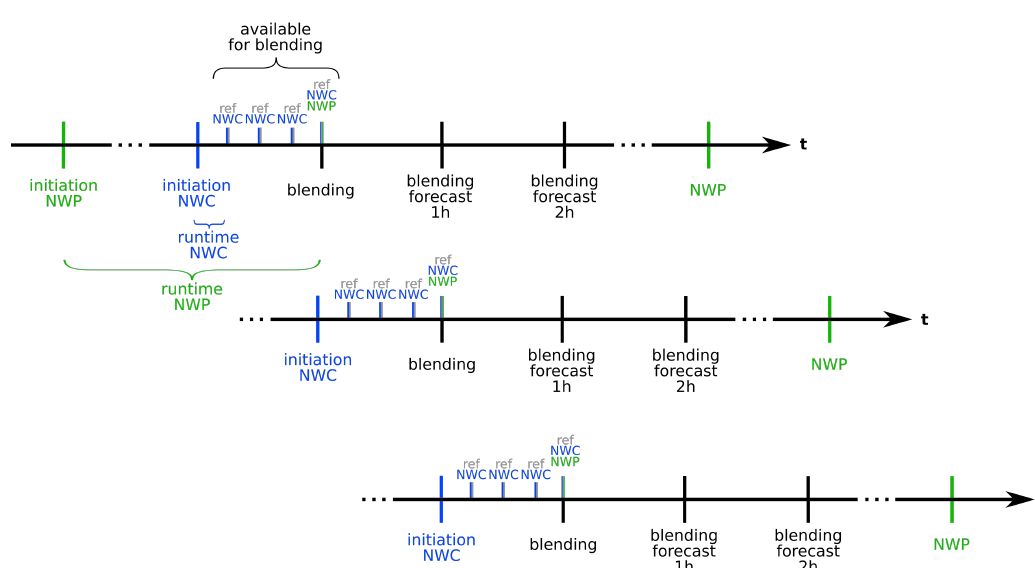
Figure 1. Scheme of the temporal availability of the input forecasts for a blending with ANAKLIM++ (adjustment of assimilation software for the reanalysis of climate data). The distance of the depicted forecasts is proportional to the time range in which they are available. The dots on the line mark a break in the time line due to a changing temporal availability and differing runtimes of the utilized NWP (numerical weather prediction) models. For each blending 1 h of NWP, NWC nowcasting and reference needs to be available. The procedure can be repeated every